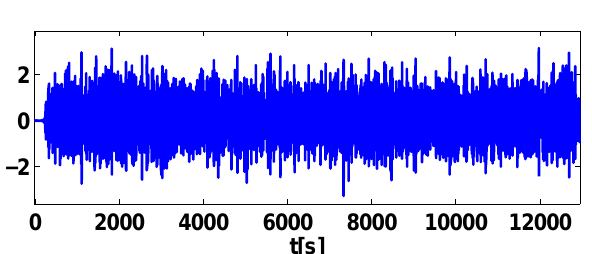
Fig. 21. Time signal as calculated by nonlinear AB at X = 2626m (solid), shifted nonlinear pm-signal predicted from time sig- nal at X obs (dashed), and Signal prediction (dotted line) for